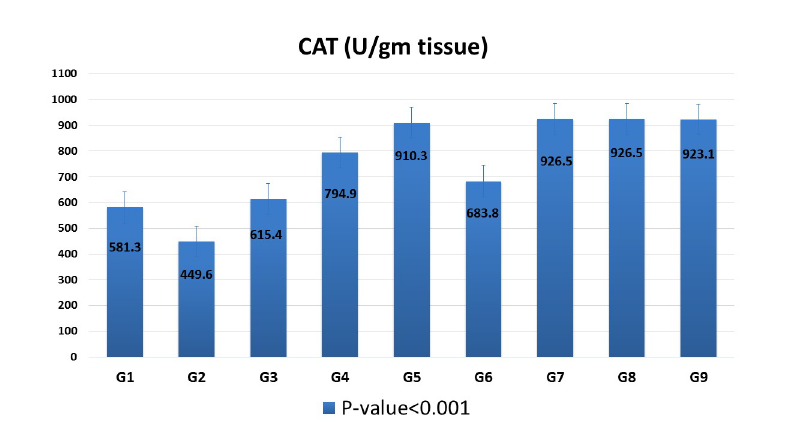
Fig 3. Effect of different treatment regimens included in the study on liver CAT level of S . mansoni infected mice groups sacrificed at 10 th week PI. Values are given as mean ± SD for 4 mice in each group. Values show high significant difference ( P <